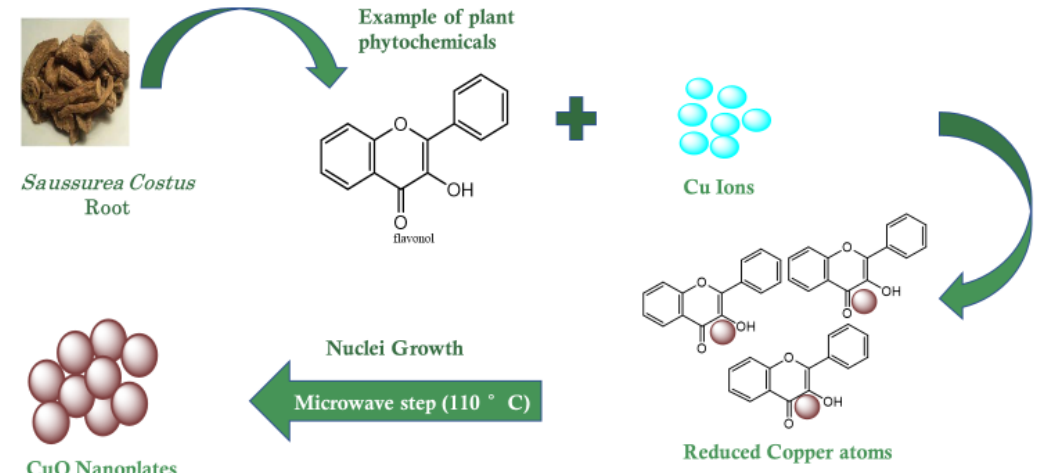
Figure 6. Possible mechanism of formation of CuO nanoplates using Saussurea costus root extract.